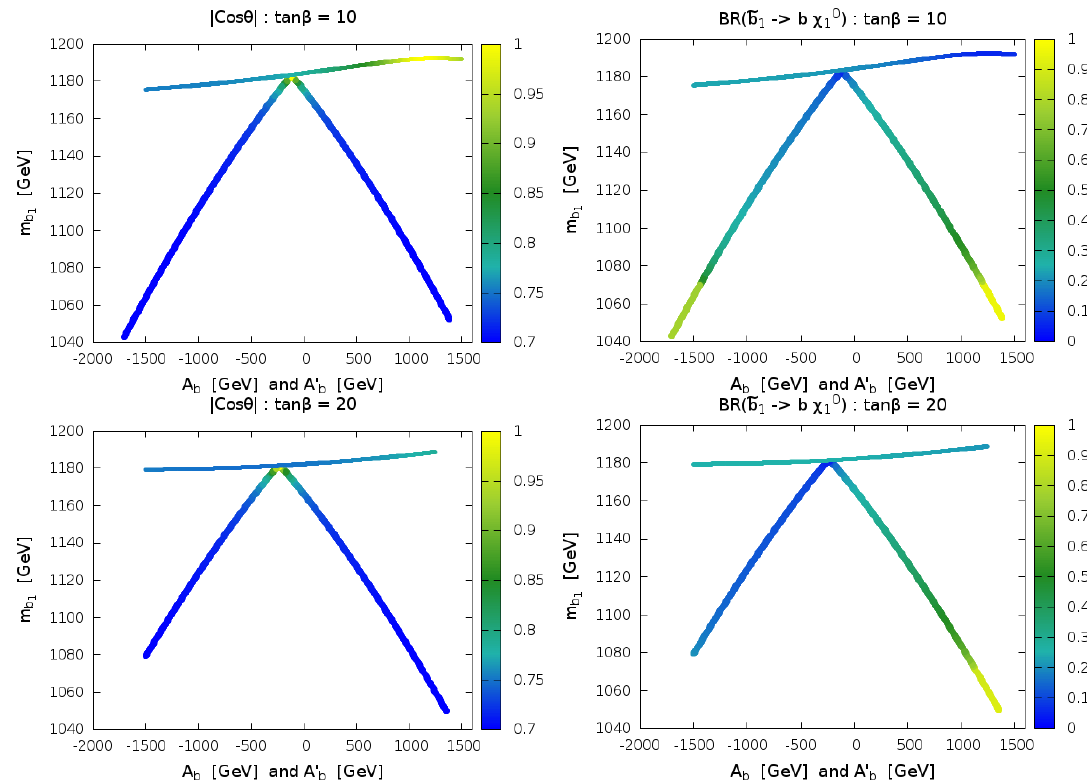
Figure 8 . Same as in (cid:12)gure 7 but for a scenario with gaugino (bino)-like neutralino LSP which is ensured by setting M 1 = 500 GeV, M 2 = 1 : 1 TeV and (cid:22) = 900 GeV while tan (cid:12) = 20 for the plots in the bottom panel. The speci(cid:12)c choice of ‘ (cid:22) ’ also ensures that the decay mode ~ b 1 be open or closed depending upon varying m ~